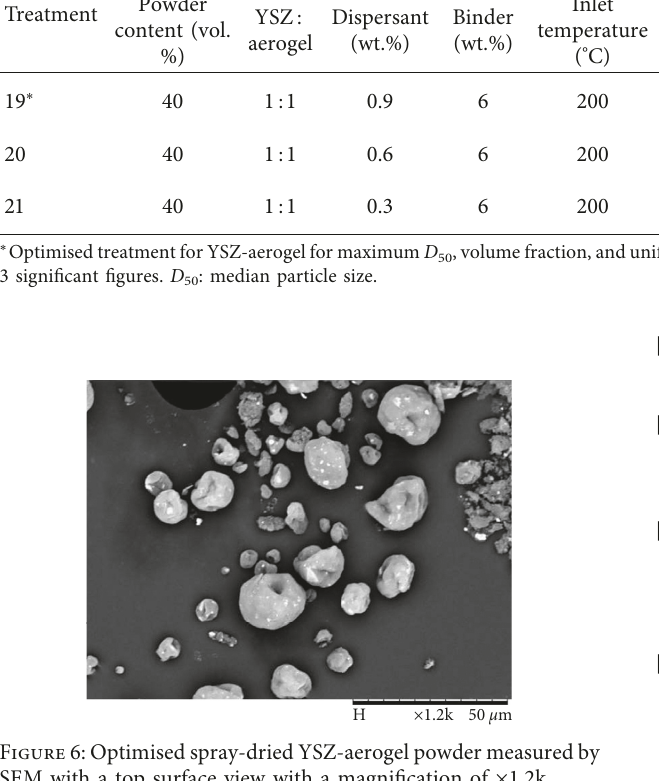
Table 6: Optimisation conditions and responses for the spray-drying process. Treatment